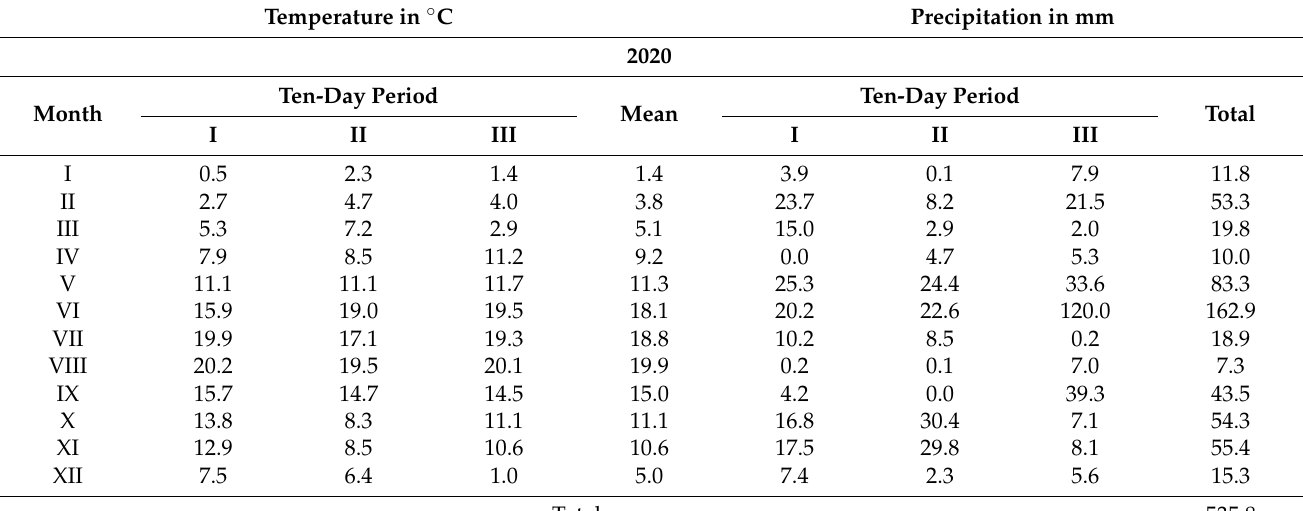
Table 3. Data on weather conditions in 2020/2021 provided by the Meteorological Station of the University of Rzesz ó